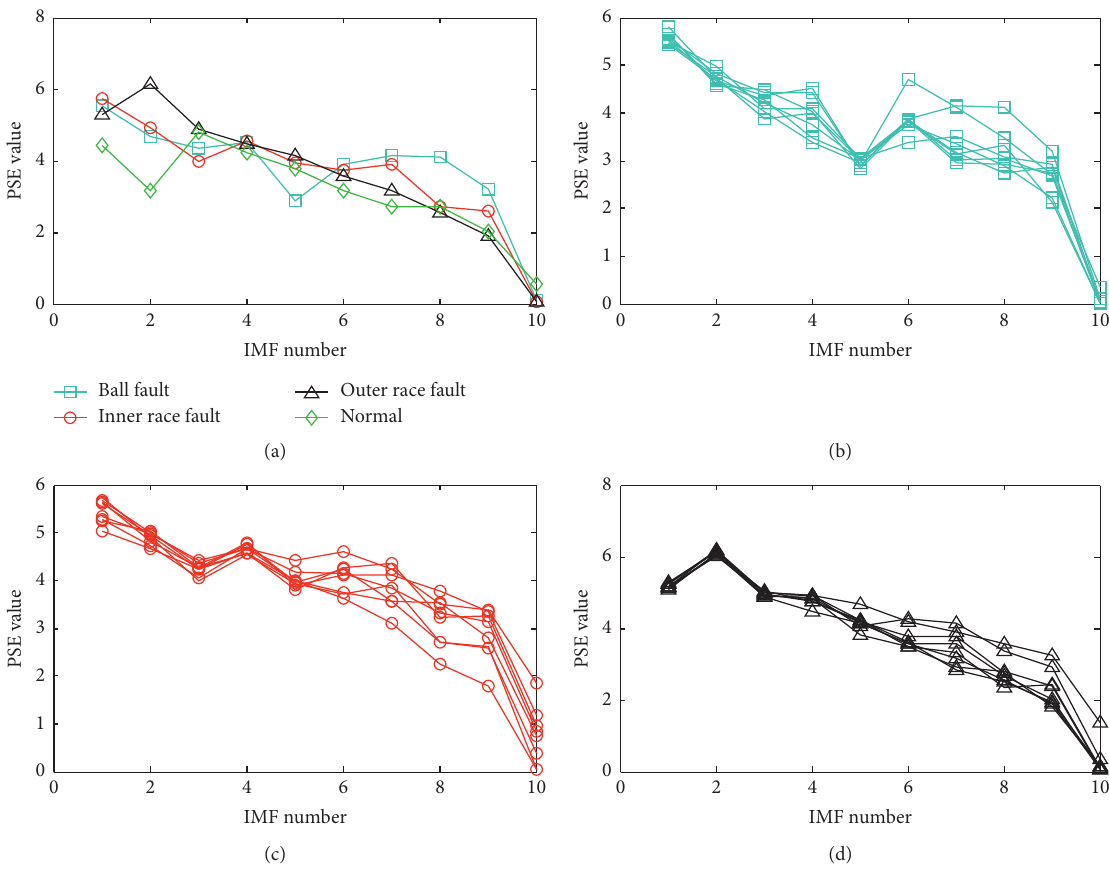
Figure 10: The distribution patterns of PSE on different IMF components. (a) The average PSE values of each IMF component of different fault conditions. (b) 8 samples of ball fault. (c) 8 samples of inner race fault. (d) 8 samples of outer race fault.